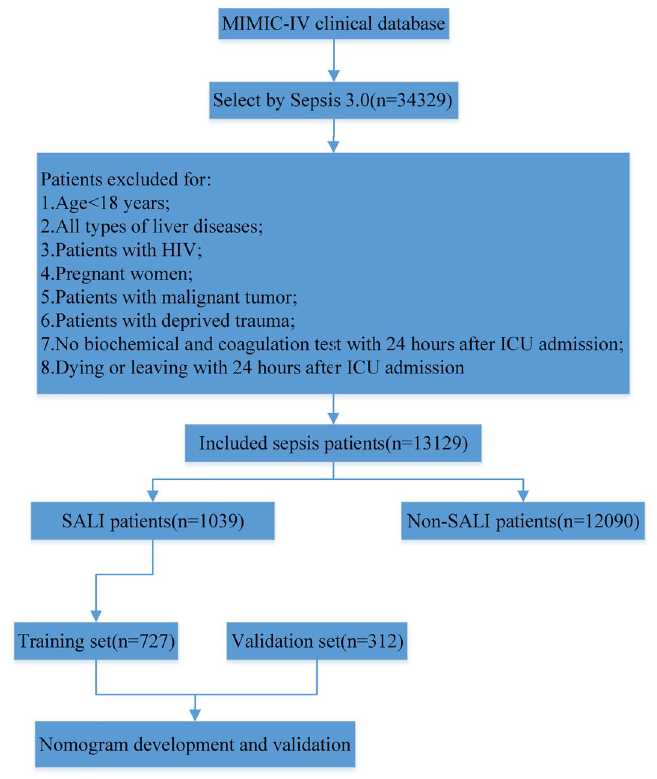
Figure 1. Flowchart of data extraction and study